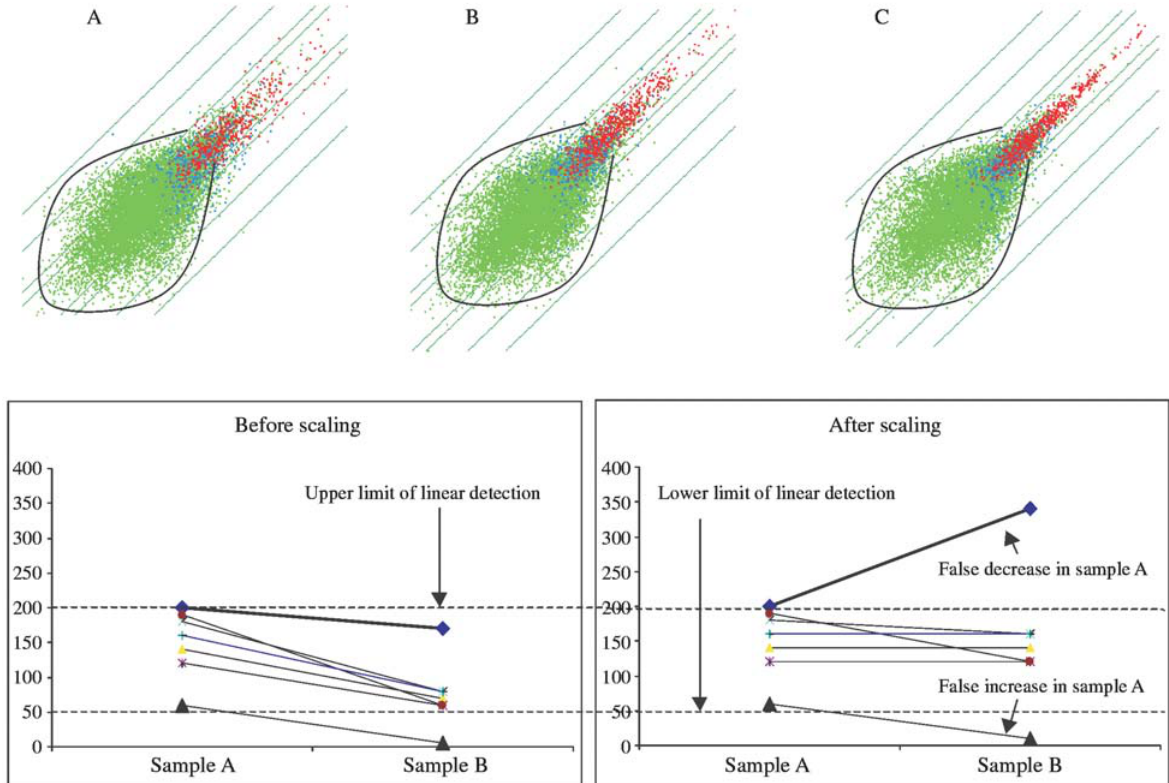
Figure 2 - Different variation patterns and scaling effects. Top panel: Comparison of variation patterns among different replicates. (A) Biological repli- cate – RNA derived from the kidney cortex of two different C57BL/6J mice. (B) Technical replicate – independent experiment with the same kidney cor- texRNA.(C)Chipreplicate–samemasterhybridizationmixappliedtotwodifferentU74Achips.Thelinear-shapedvariation(reddots)decreasesasthe potential source of variability decreases, while the elliptical variation (green dots) is constant across the three experimental designs. The parallel green linesrepresent,fromtheinsidetooutside,2-,3-,10-,and30-folddifferences.Bottompanel:Differenteffectsofglobalscaling.Toillustratethescalingef- fects, the average signal intensity of sample B was set at 2-fold lower than that of sample A. The average intensity of sample A was set at the designated scalingtargetintensity.Thegenesoutsidethelineardetectionrangewerefalselyincreasedatthelowerlimitrangeandfalselydecreasedattheupperlimit range to compare sample A with sample